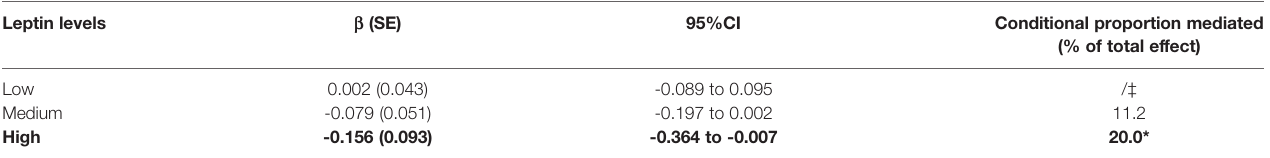
(% of total effect)